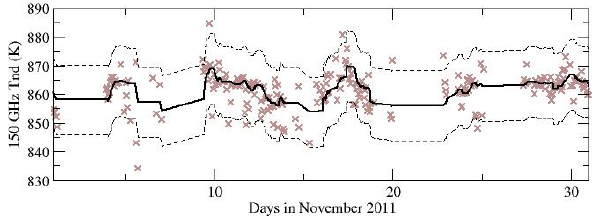
Fig. 3. Self-calibration of the ARM MWRHFs. Brown points are the instantaneous noise injection temperature values derived from tip curves. The black solid line is the median calculated value and the dashed lines are 2 standard deviations of the measurements. The data were collected at the SGP site during the month of November 2011.